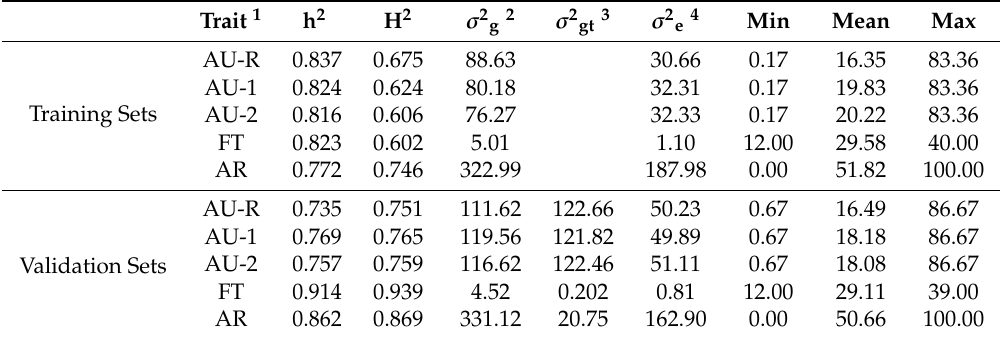
Table 1. Descriptive statistics of the traits studied specified in the training and validation sets.